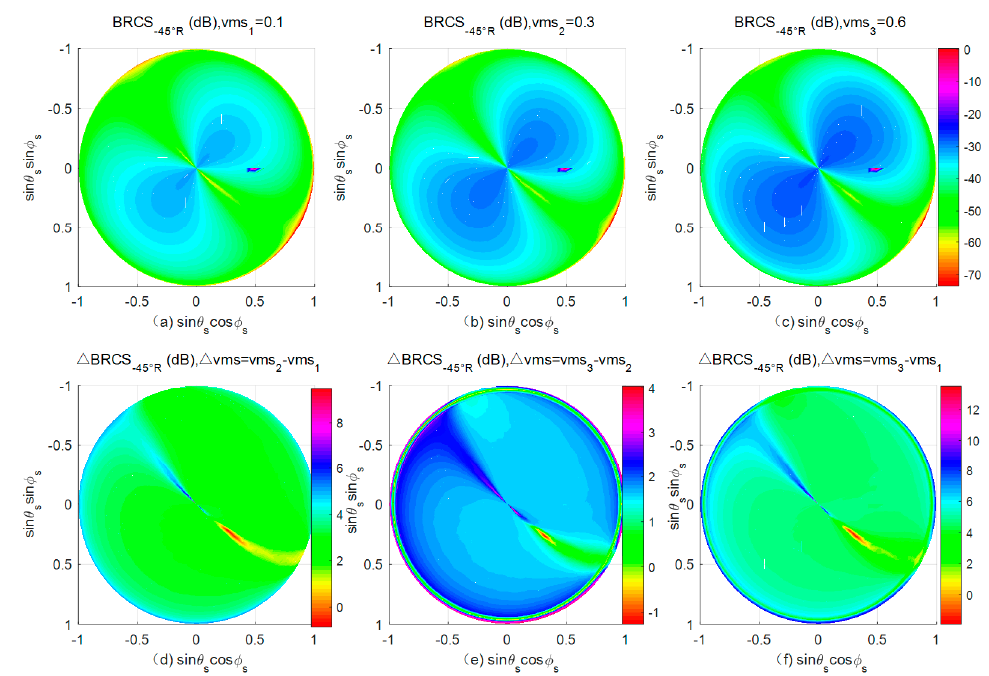
Figure 12. BRCS for different soil moisture contents ( a – c ) and the BRCS differences for different soil moisture differences ( d – f ) at –45° R polarization.